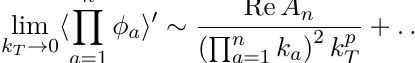
Figure 1. The figure shows CMB dipole at the level of 3 mK align with the ± β perpendicular directions ± β × and ± β ⊥ are also shown for reference. This observation highlights the existence of a preferred frame in our universe and hence implies the spontaneous breaking of boost